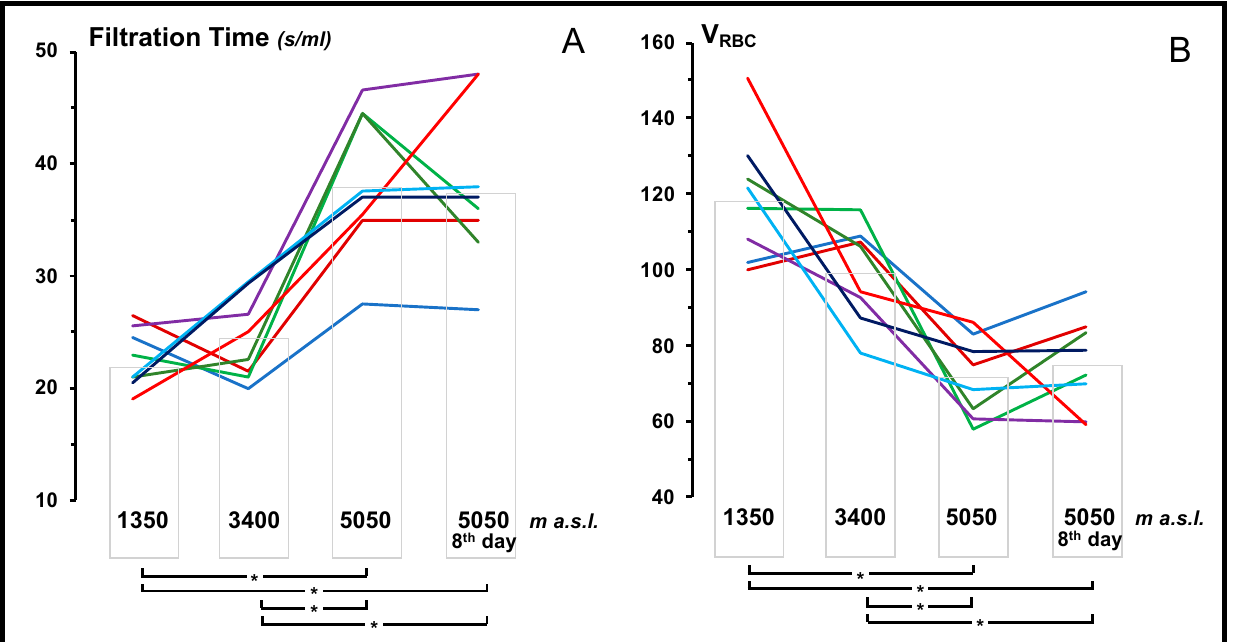
Figure 2. Blood Filterability in European lowlanders at different altitude. A: Filtration time required by 1 mL of whole blood to pass through 5 µm pore-membranes under a negative pressure of 20 cm H 2 O. B: volume of red blood cells filtered per minute, corrected by the haematocrit (VRBC = 60/filtration time (s) × Hct). a.s.l. = above sea level. * p < 0.001.